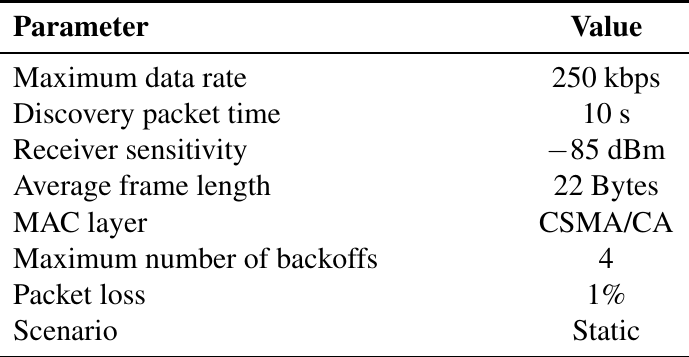
Table 2. Parameters for the tested